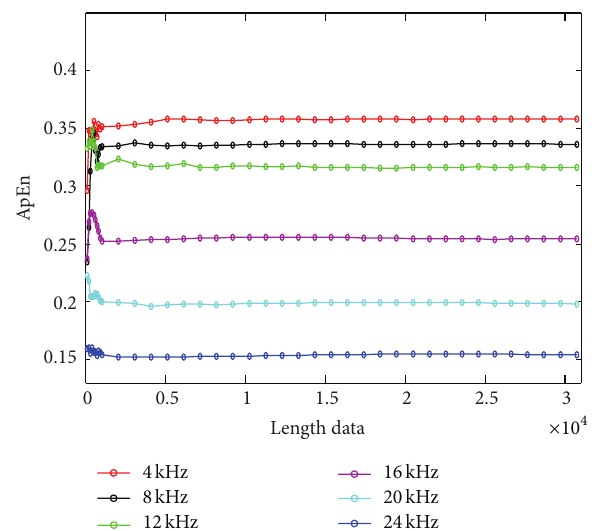
Figure 6: The calculated ApEn values by different parameters (length of the data and the sample